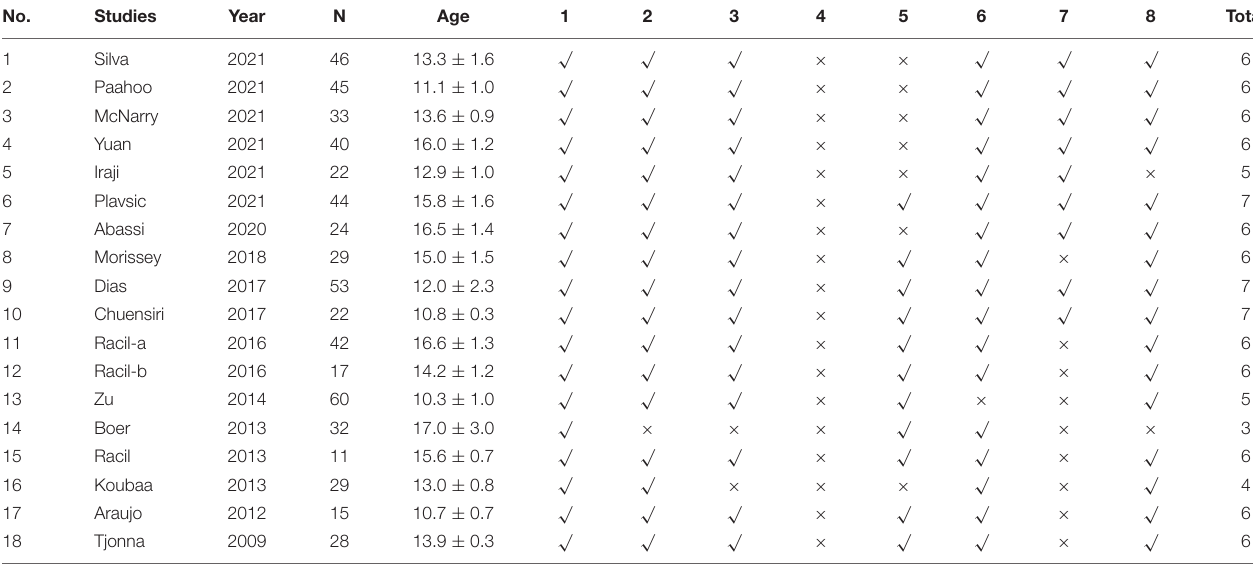
TABLE 1 | Risk of bias assessment of the included